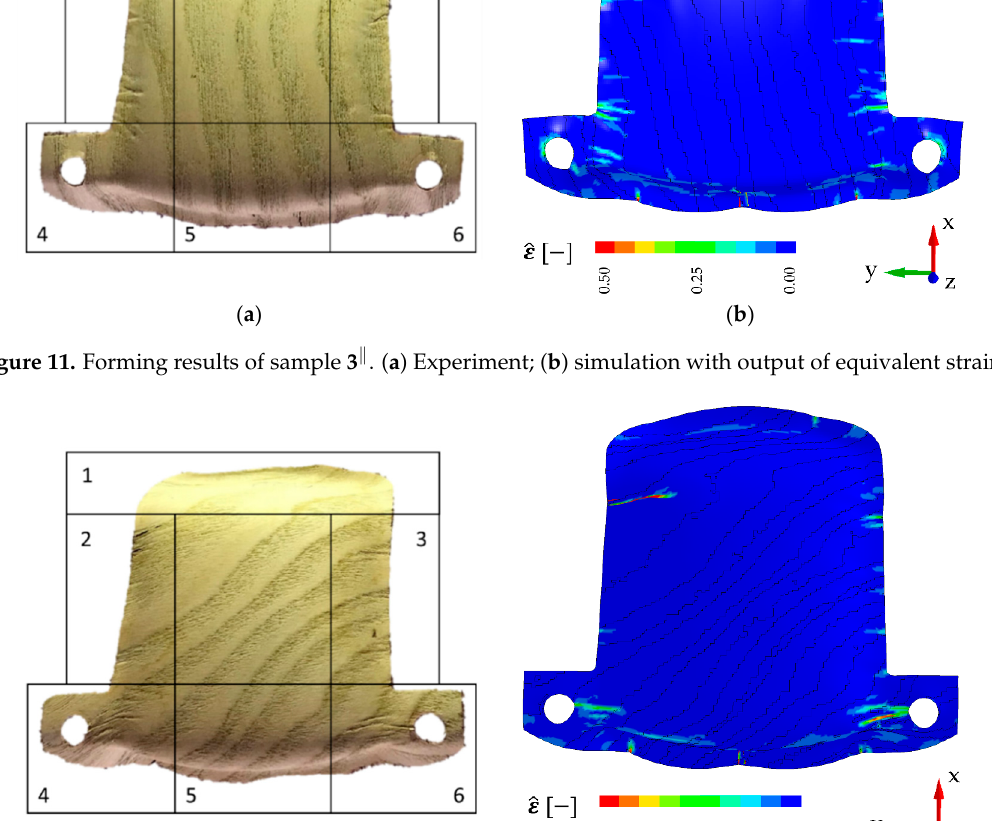
Figure 12. Forming results of sample 𝟒 (cid:2884) . ( a ) Experiment; ( b ) simulation with output of equivalent